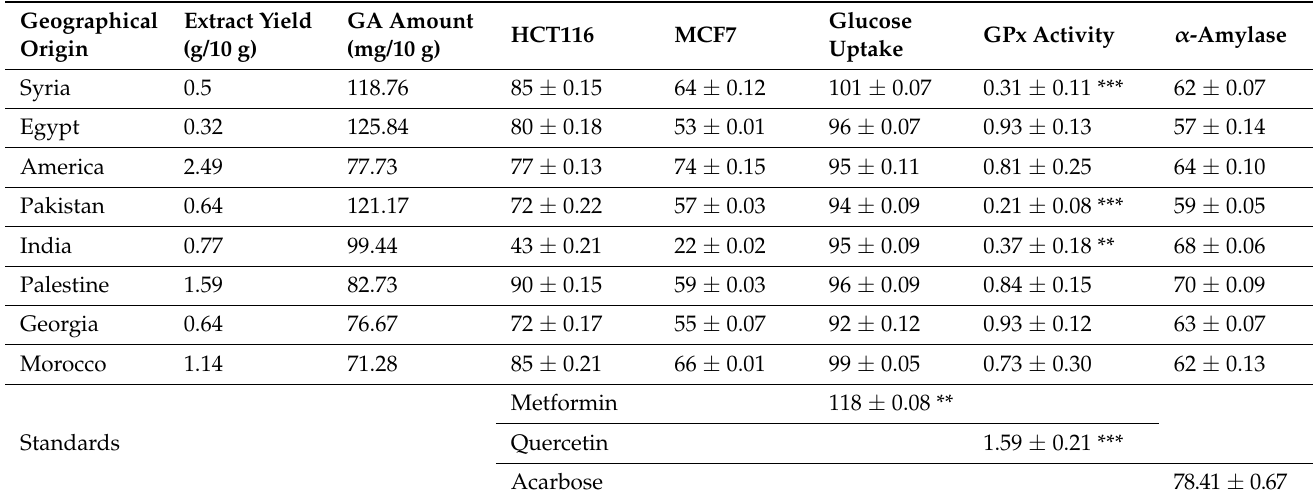
Table 1. Extract yield, GA amount, and the data for activity screening of licorice samples. (** P =0.05, *** P =0.01)